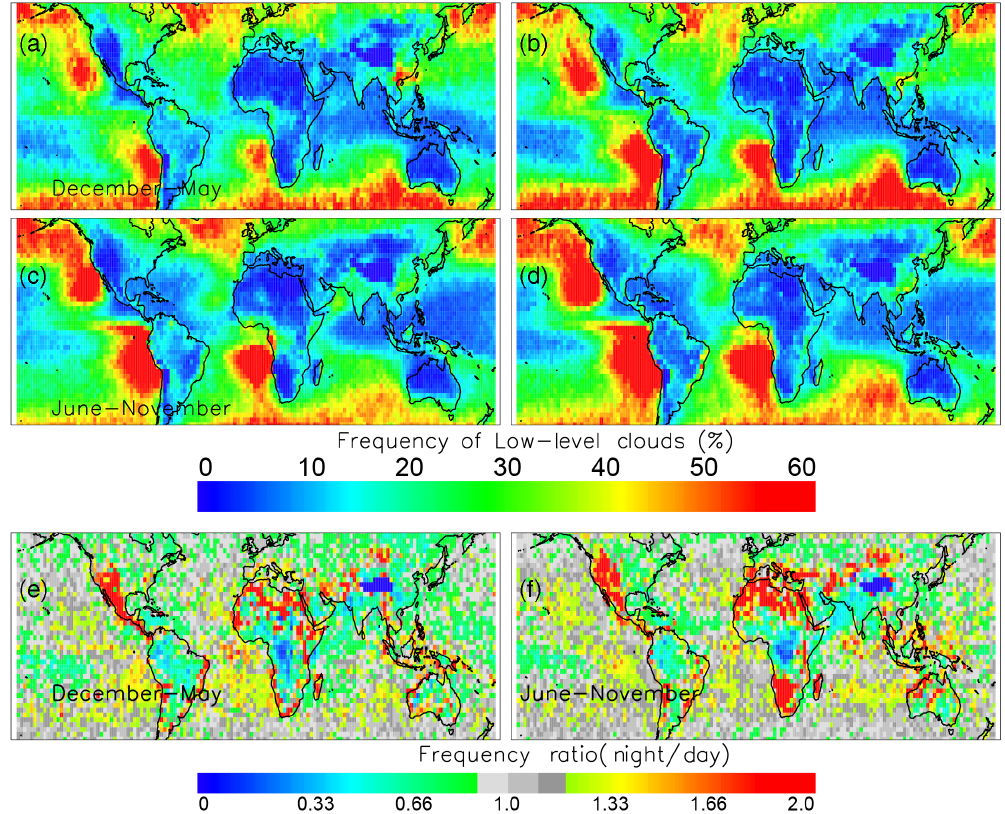
Figure 6. Multi-year (June 2006 to November 2013) frequency of occurrence of low-level clouds defined by CALIOP as the ratio of pix- els with COD greater than 0 with cloud-top height<3km to the total number of CALIOP scenes within the current 2.5 ◦ × 2.5 ◦ bin for (a) December to May during daytime observations, (b) December to May of nighttime observations, (c) daytime frequency of occurrence of low-level cloud decks defined similar to (a) during the June–November time frame, and (d) nighttime frequency of occurrence of low-level cloud decks for the same time frame as (c) . Panels (e, f) depict the night- to daytime frequency ratio for the December to May and June to November periods,